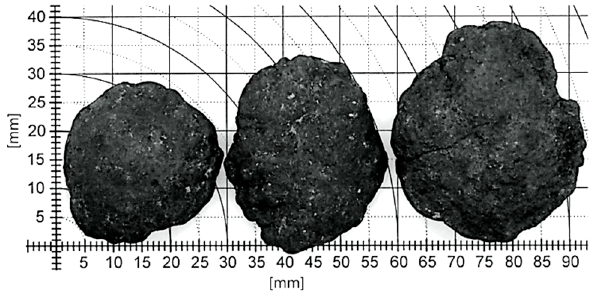
Figure 2. Examples of external views of polymetallic nodules.